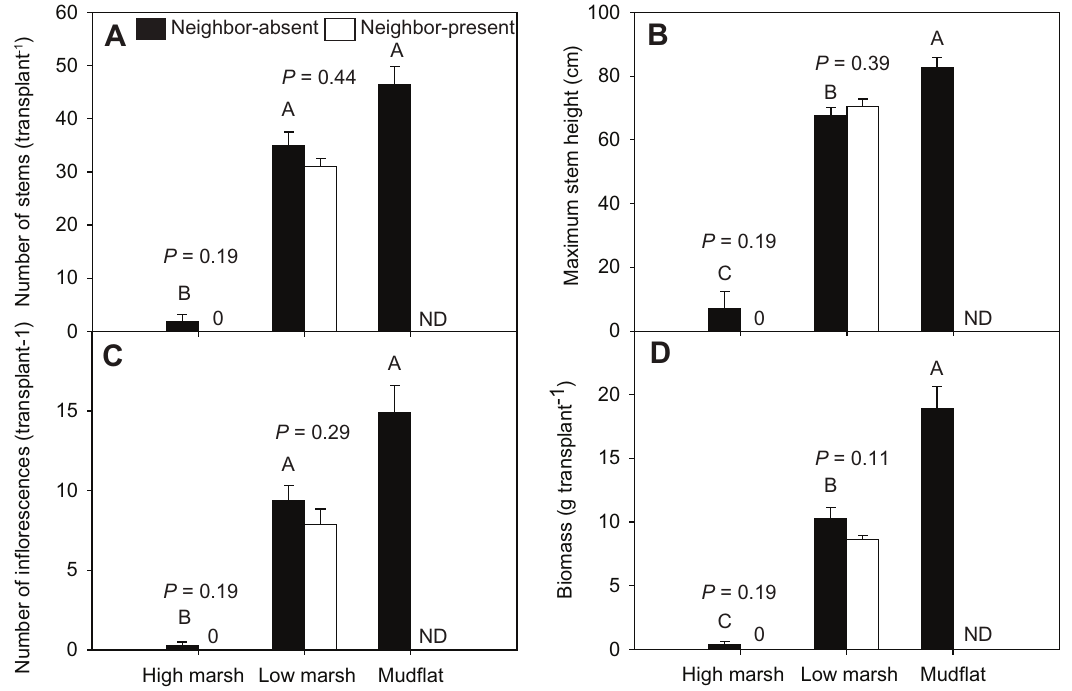
Figure 3. Cordgrass performance in different zones at the estuarine site in 2010. (A) number of stems (B) maximum plant height (C) number of inflorescences and (D) biomass. Data are means + 1SE. ND indicates no data. Bars sharing a capital letter were not significantly different from one another (nonparametric multiple comparisons, Steel-test). P -values from ANOVAs or Wilcoxon tests investigating the effect of neighbors are indicated above each bar group for low marsh and high marsh transplants.